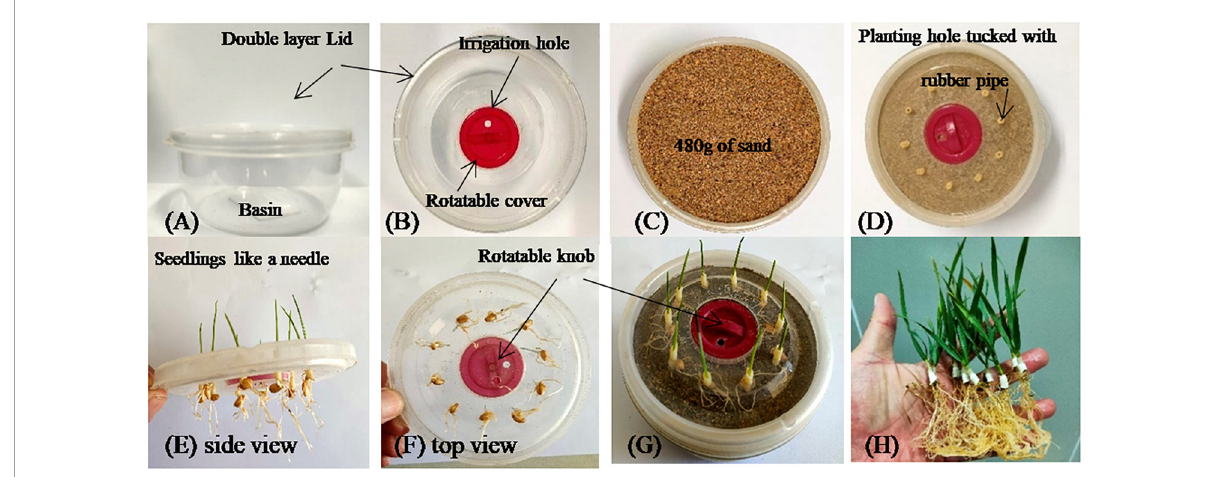
FIGURE1 The technological process of the pot experiment evaluating wheat TE response to gradients of soil water contents. The top view and side view of the pot is shown in panels (A,B) . The pot is filled with sand (C) . The lid was placed on the pot with sand after planting holes were tucked with rubber pipe 6 ∼ 8 mm long (D) . Seedlings were tucked into the rubber pipe after growing into a needle shape in a petri dish (E,F) . The pot was covered with lid with seedlings after being watered 1 higher above the target soil moisture (G) . The pot was broken using hacksaw for taking photograph (H) . If a whole plant is not needed, the seedlings could be cut off outside the pot using scissors first, and continue to be cut into aboveground and belowground parts from the node between root and shoot, after removing the